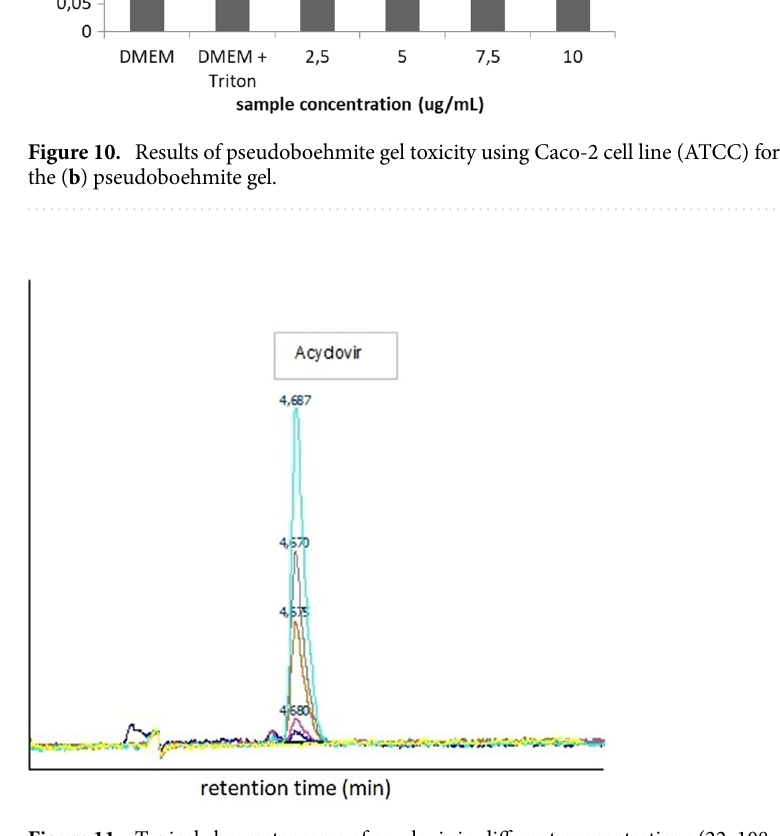
Figure 11. Typical chromatograms of acyclovir in different concentrations (22, 108, 542, 1084 and 1626